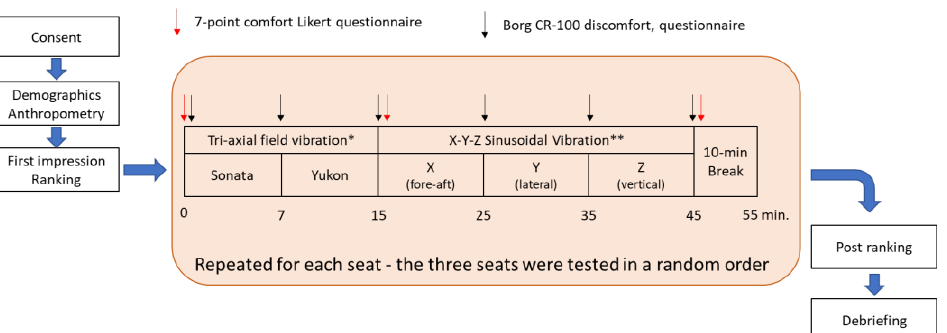
Figure 3. Lab test protocols. * Trial-axial field vibration was randomized between Sonata and Yukon. ** X-Y-Z Sinusoidal vibration was randomized among the axes.